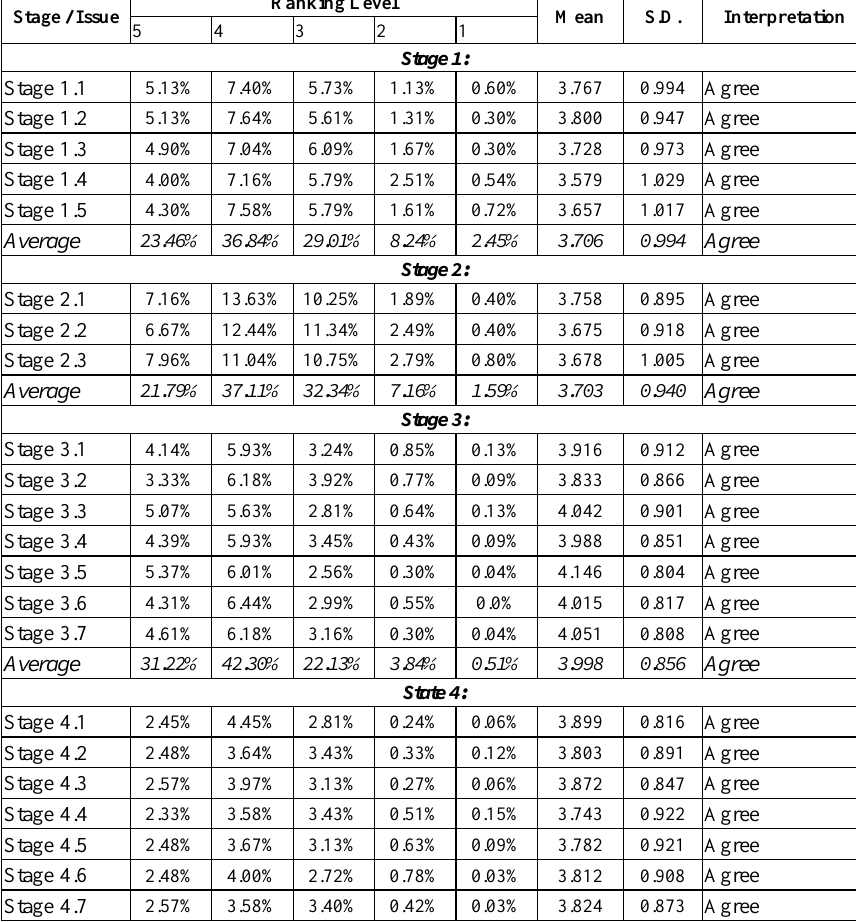
Table 6. Satisfaction with online learning management on the impact of